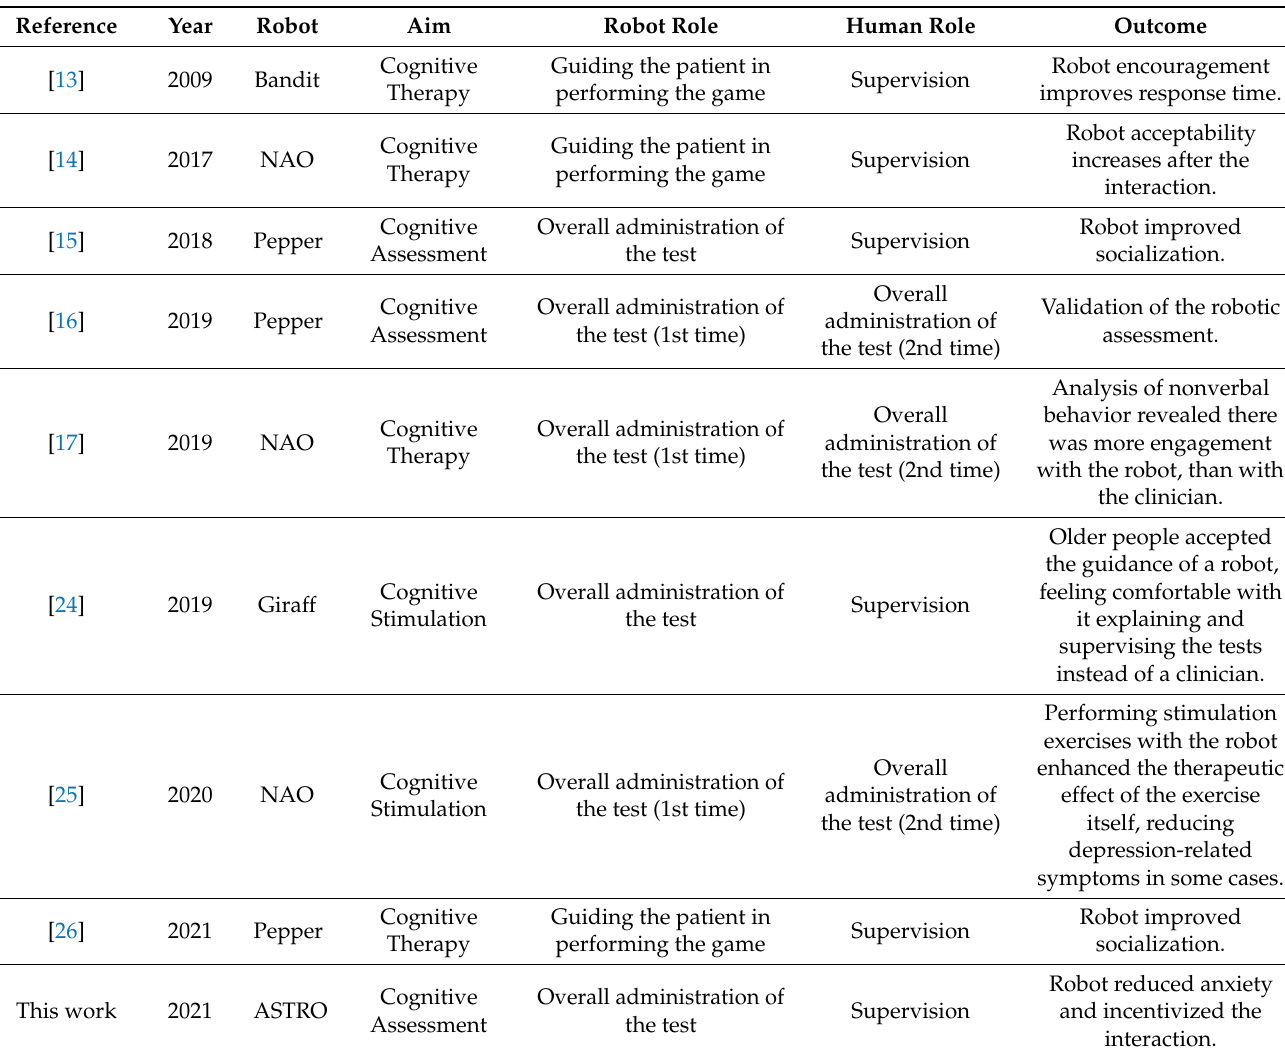
Table 1. Related works of socially assistive robotics in cognitive assessment, stimulation, and therapy, tested with elderly